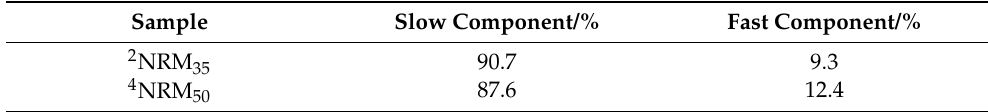
Table 1. Quantitative estimation of the amount of slow and fast components from the ESR spectra measured at 75 ◦